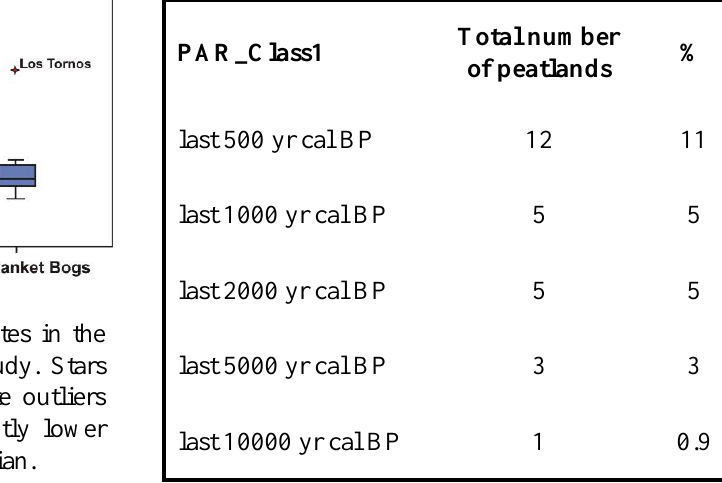
Table 2. Number and percentage of all peatlands considered as belonging to Class 1 of vertical peat accumulation rates (< 15 yr cm -1 ), grouped by different periods of the Holocene (yr cal